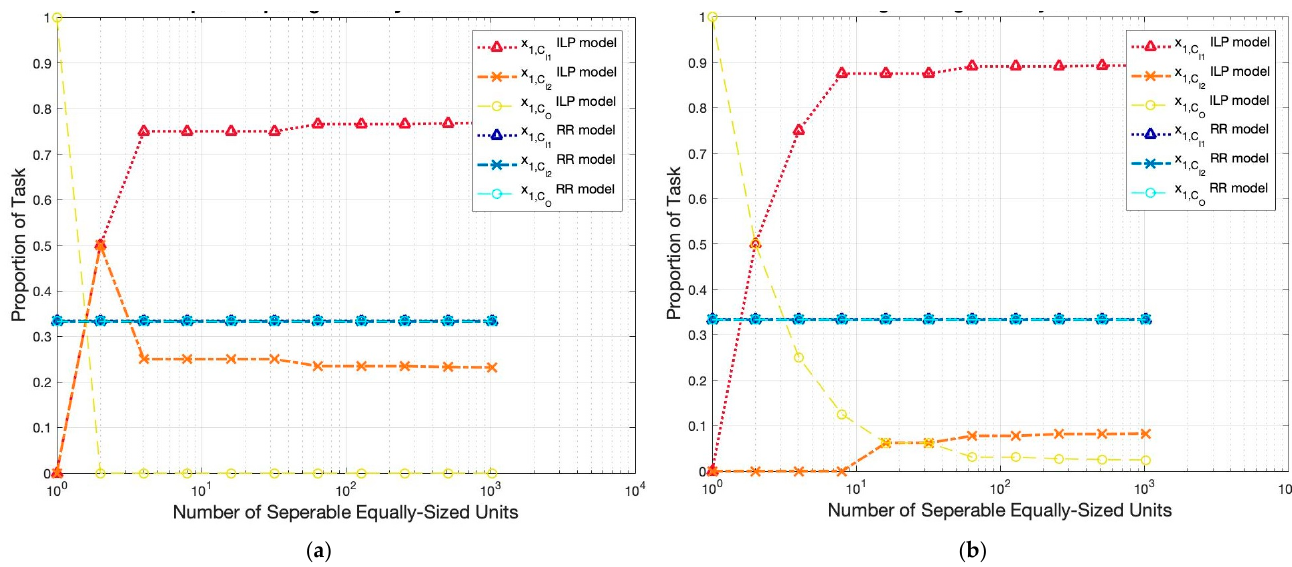
Figure 7. Proportion of task in case study 3: ( a ) peer-to-peer federated cluster scenario; ( b ) edge-core cluster scenario.